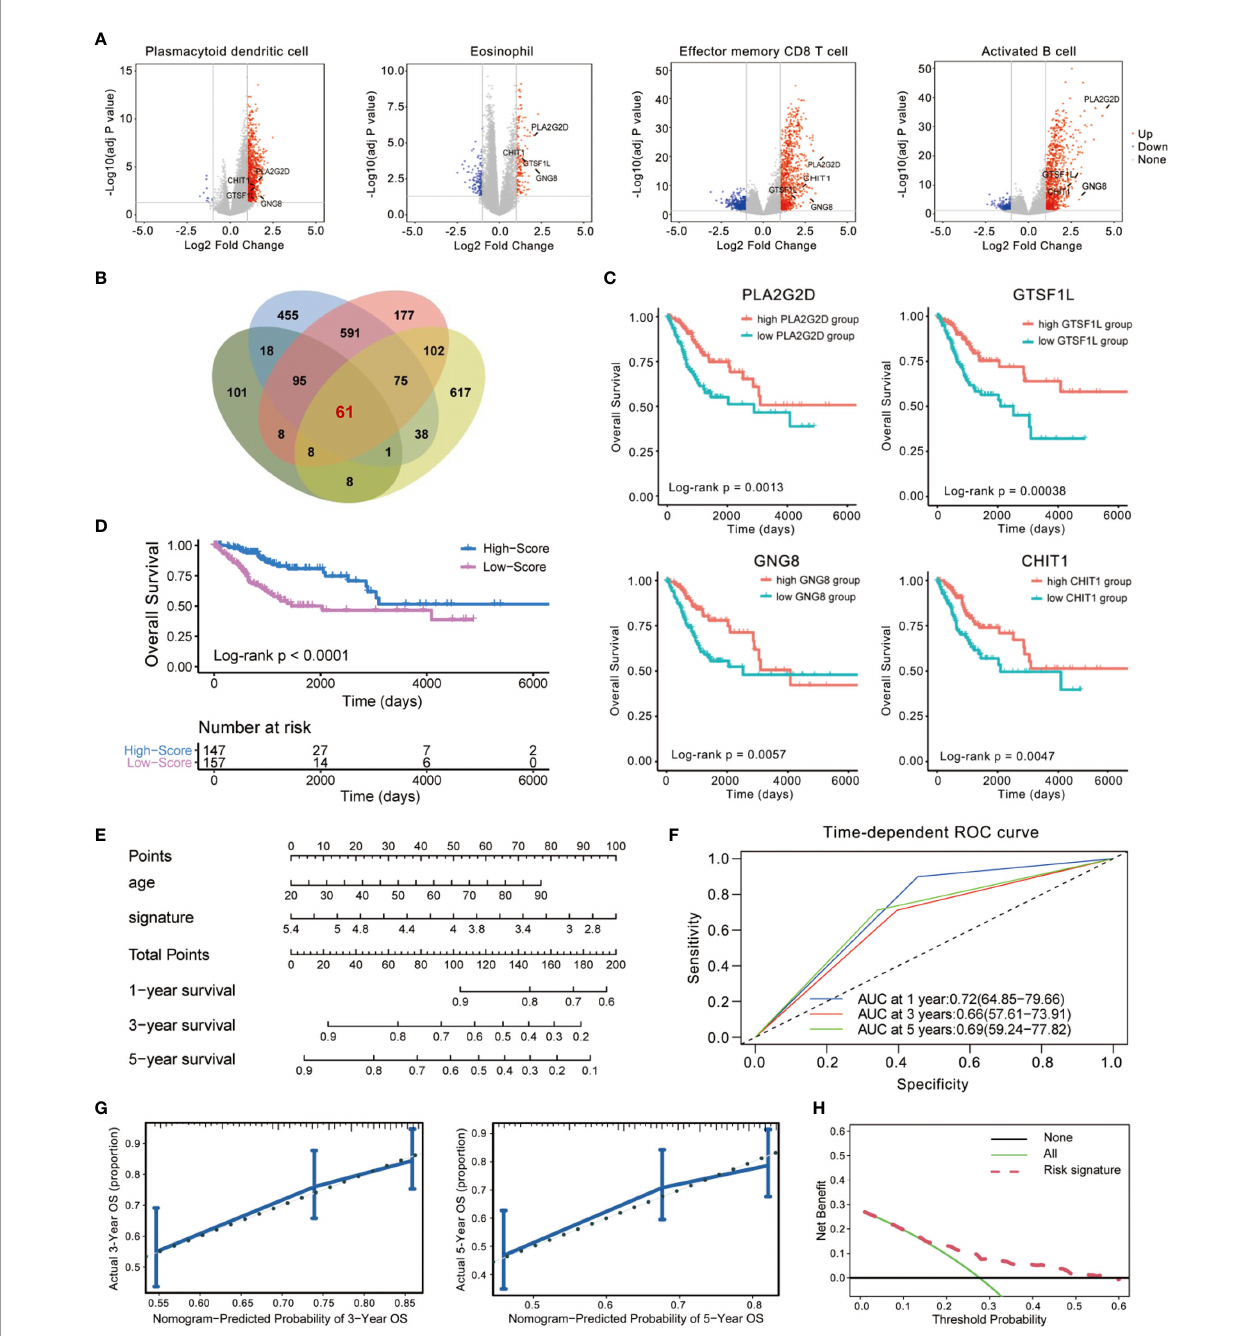
FIGURE 3 | Establishment of an immune-related prognostic signature using Cox regression analysis. (A, B) Identi fi cation of differentially expressed genes (DEGs) using TCGA cohorts and annotation of Ensembl. The volcano plot (A) and Venn diagram (B) are shown. (C) Kaplan – Meier curves for overall survival (OS) of all CESC patients with the four immune-related genes. Log-rank test showed p < 0.01, respectively. (D) Patients in the high-score group displayed a longer overall survival time tested by Kaplan – Meier test. (E) Construction of a nomogram combining Immunoscore with clinical feature (age) for survival prediction. The Immunoscore presented as an independent prognostic predictor by multivariate Cox regression. (F) The 1-, 3-, and 5-year ROC of the optimal model suggested that the AUC values were approximately 0.70. (G) Calibration plot showing that nomogram-predicted survival probabilities corresponded closely to the observed proportions. (H) The decision curve analysis (DCA) of the immune